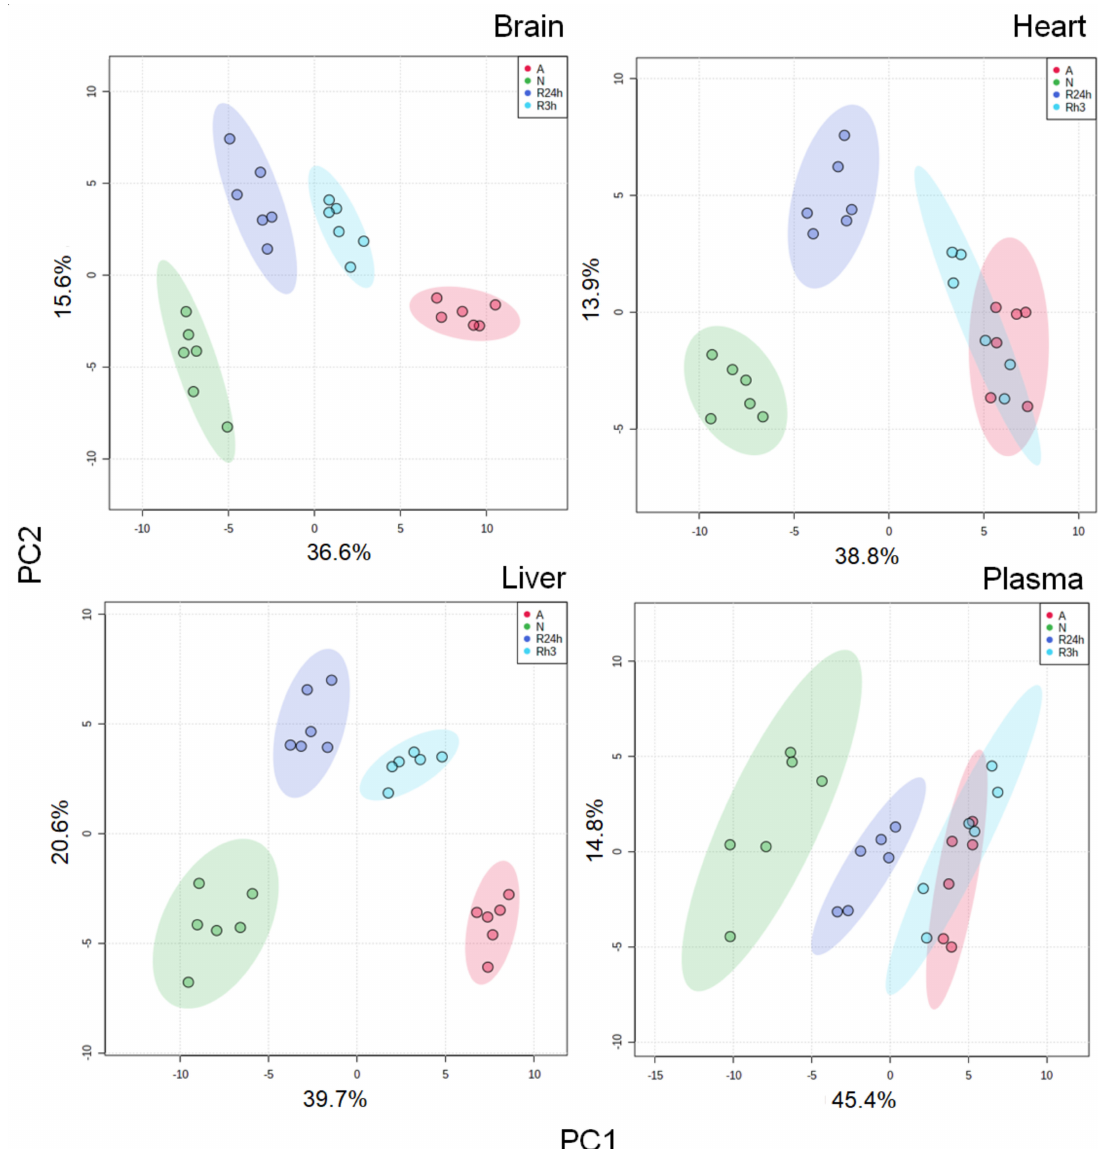
Figure 1. PCA plots. PCA plots for brain, heart, liver, and blood plasma for all exposure groups. A, anoxia; N, normoxia (control); R3h, 3 h reoxygenation; R24h, 24 h reoxygenation. PC1 and PC2: Principal component 1 and principal component 2. Each point represents a metabolite profile of a biological replicate ( n = 6 for each group). The shaded area indicates the 95% confidence